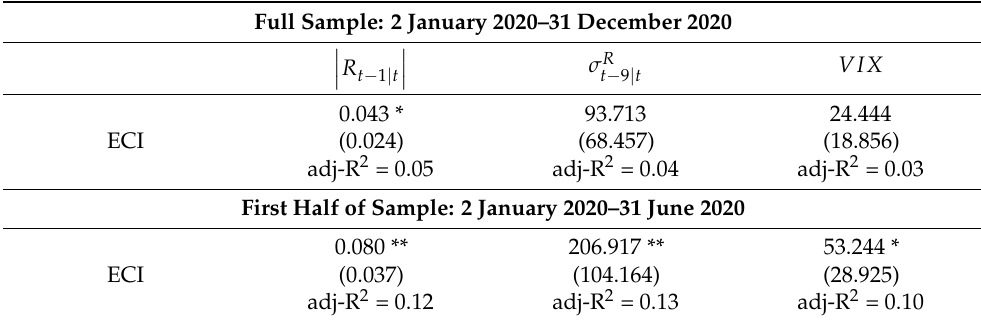
Table 3. OLS Regressions of ECI on Stock Market Volatility.